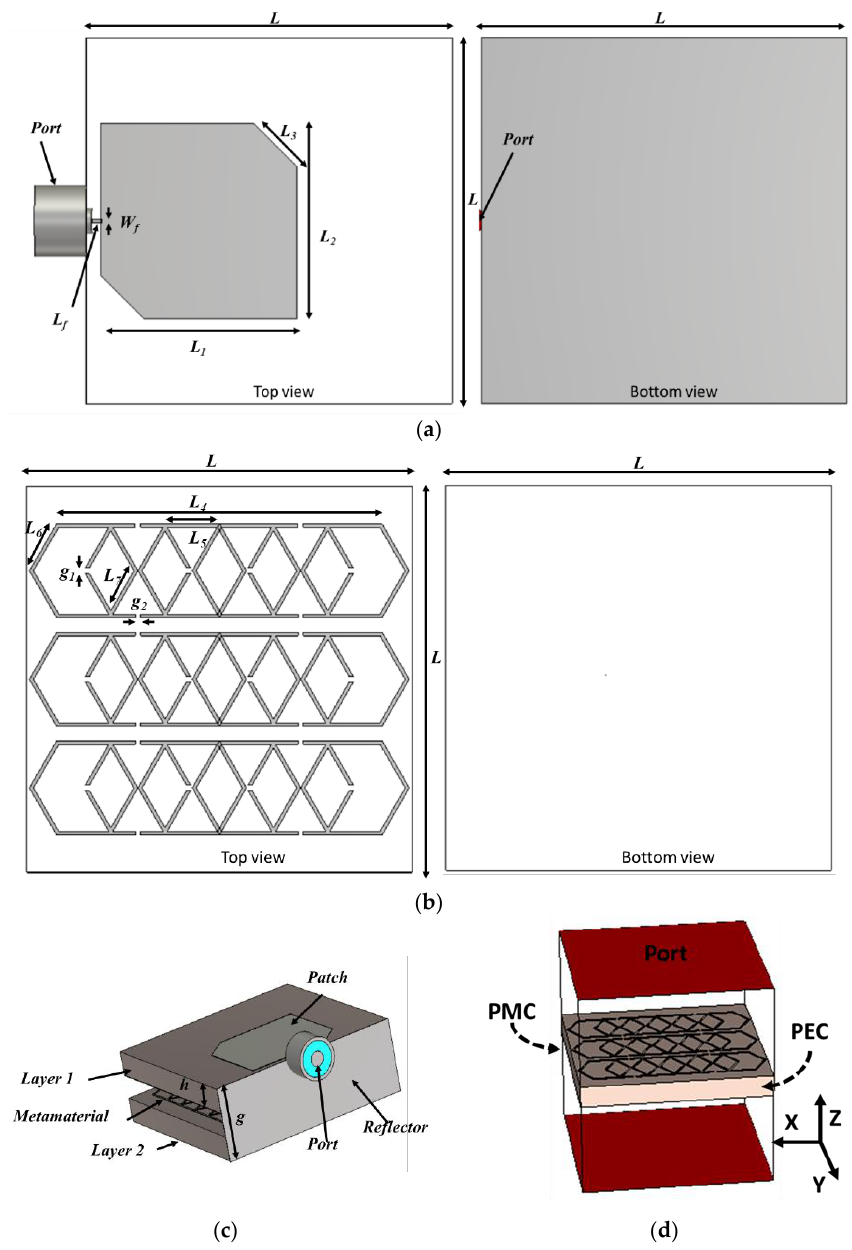
Figure 1. ( a ) Layer 1, ( b ) Layer 2, ( c ) perspective view and ( d ) Simulation setup of the metamaterial. Table 1. Layout parameters of the presented